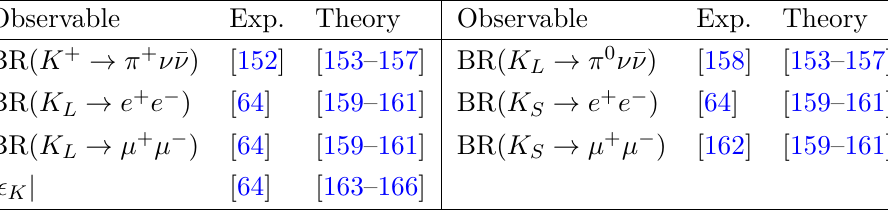
Table 9 . The “ K FCNC” observables used in smelli , along with the relevant experimental measurements and theory papers used in the computation.